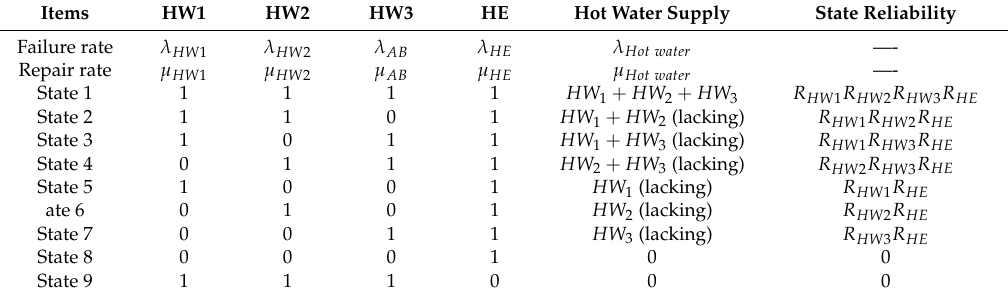
Table 10. The operation states and reliability data for the hot water subsystem of the CCHP system. Items HW1 HW2 HW3 HE Hot Water Supply